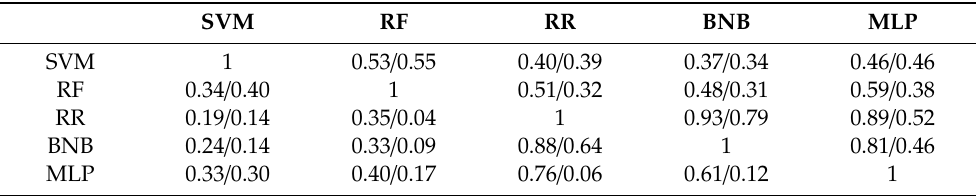
Table 4. Median pairwise Pearson / Spearman correlation at feature (gene expression) importance ( I f ) level. Figures above main diagonal: With FloWPS; figures below: Without